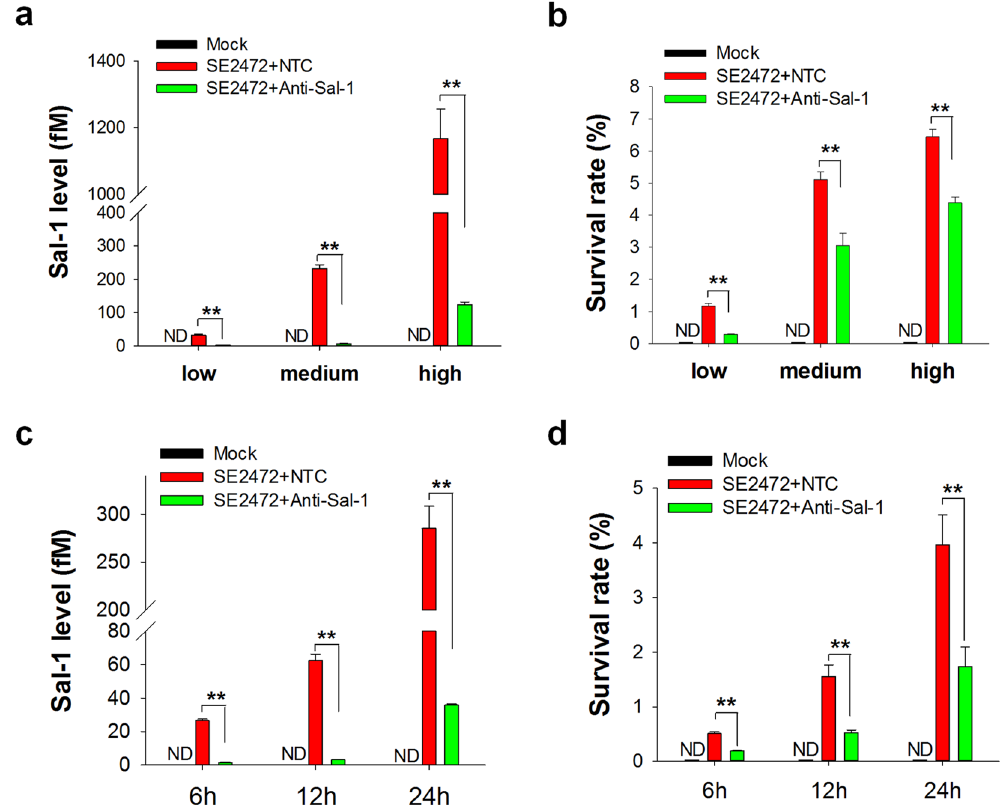
Figure 5. Sal-1 facilitates the intracellular bacterial survival following Salmonella infection. (a ) Depletion of cellular Sal-1 by anti-Sal-1 oligonucleotide in HT-29 cells infected with SE2472 at MOI of 1, 10 and 100. ( b ) Bacterial survival rate in HT-29 cells infected with SE2472 at MOI of 1, 10 or 100. ( c ) Depletion of Sal-1 by anti- Sal-1 oligonucleotide in HT-29 cells infected with SE2472 for 6, 12 or 24 h. ( d ) Bacterial survival rate in HT-29 cells infected with SE2472 for 6, 12 or 24 h. Data are presented as the mean ± SEM (n = 3). ND, not detected. ** P <